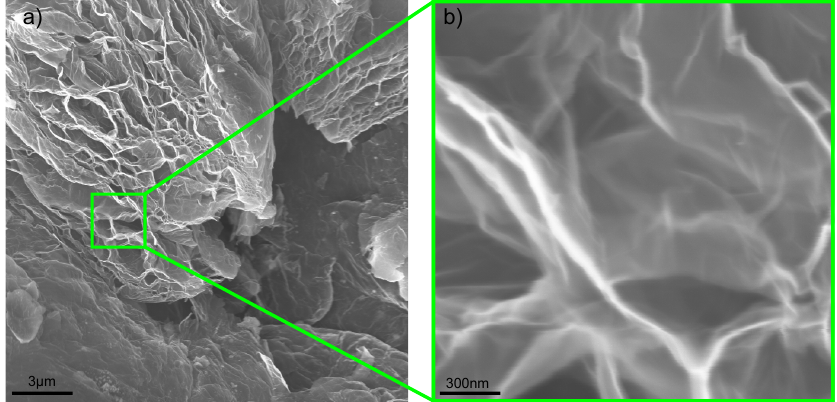
Figure A7. SEM images for FLG Avan2 at magnifications of ( a ) 10k and ( b ) 150k.